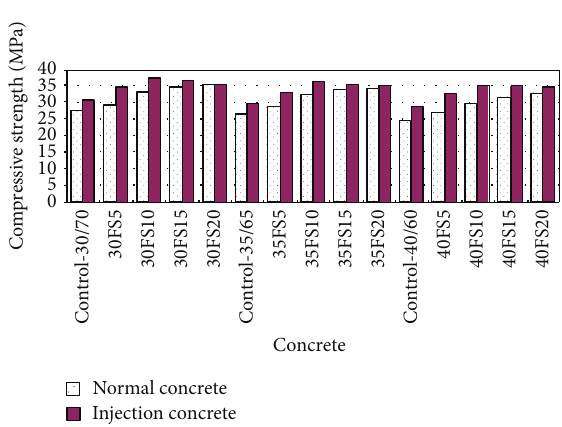
Figure 2: Compressive strength of concrete with silica fume additive.